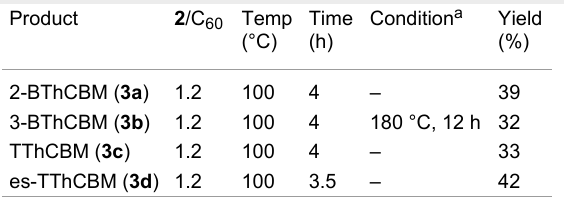
Table 1: Reaction conditions and yields of